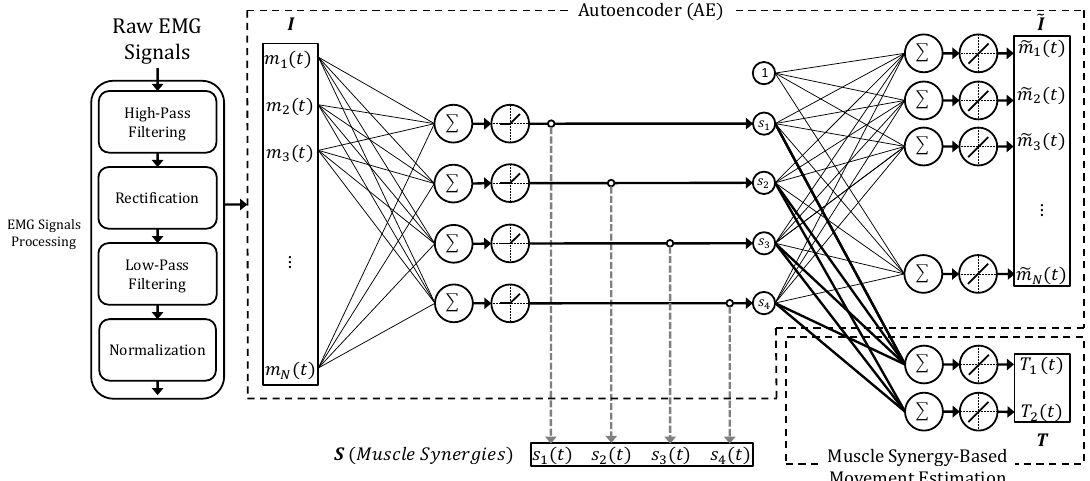
Figure 2. The proposed Autoencoder-based neural